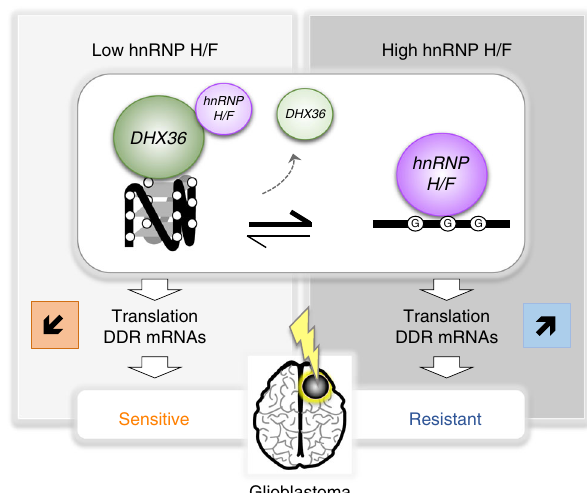
Fig. 7 Model for the role of hnRNP H/F-RG4 interactions in regulating mRNA translation of mRNAs linked to GBM response to